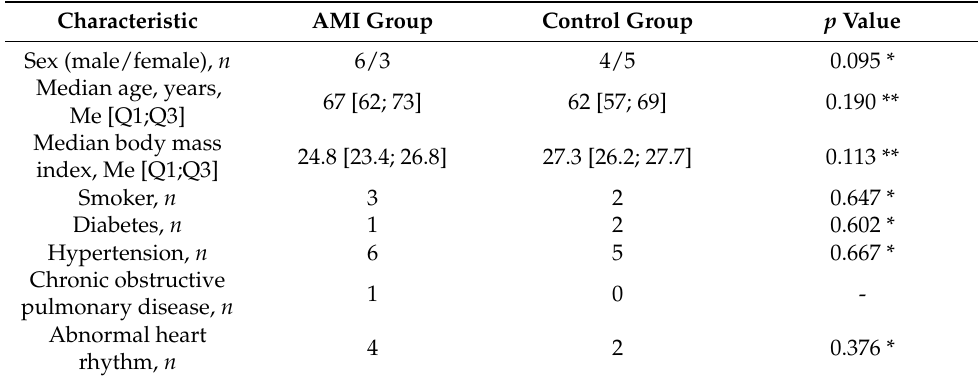
Table 1. Characteristics of the patient groups.